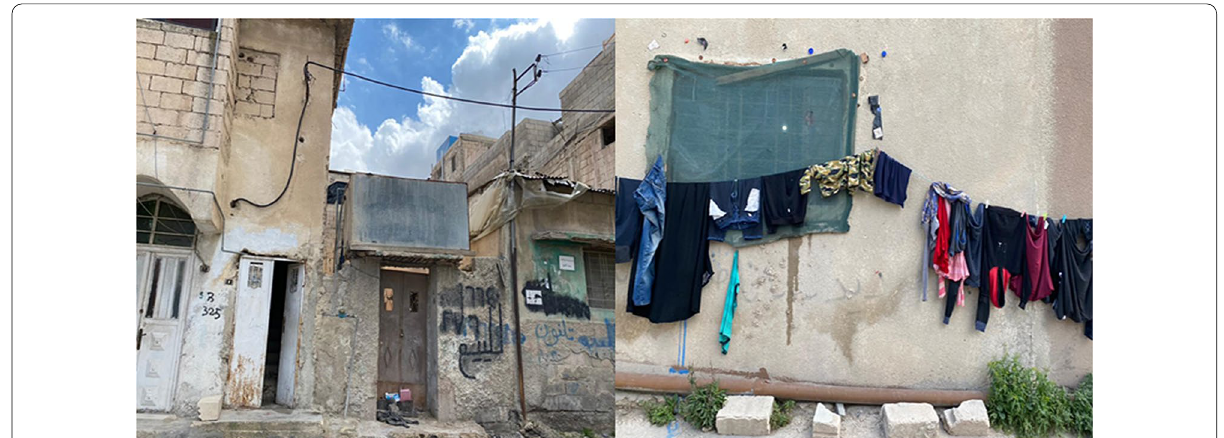
Fig. 4 Refugee camps as socio-cultural spaces and places (Source: Author